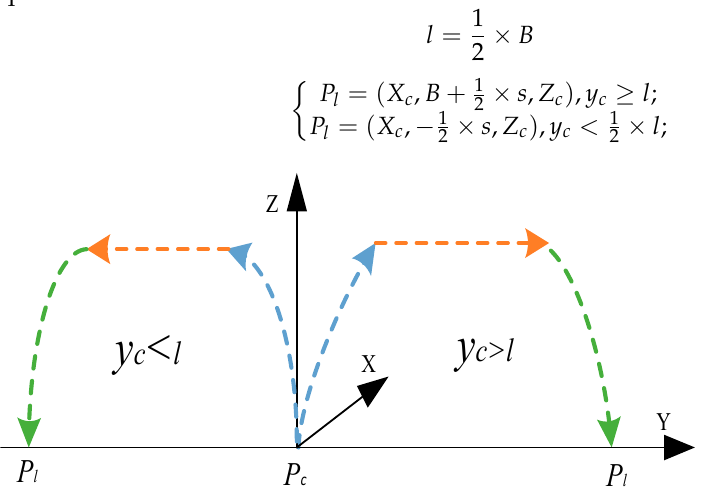
, and the coordinates of the . The coordinates of the placement point